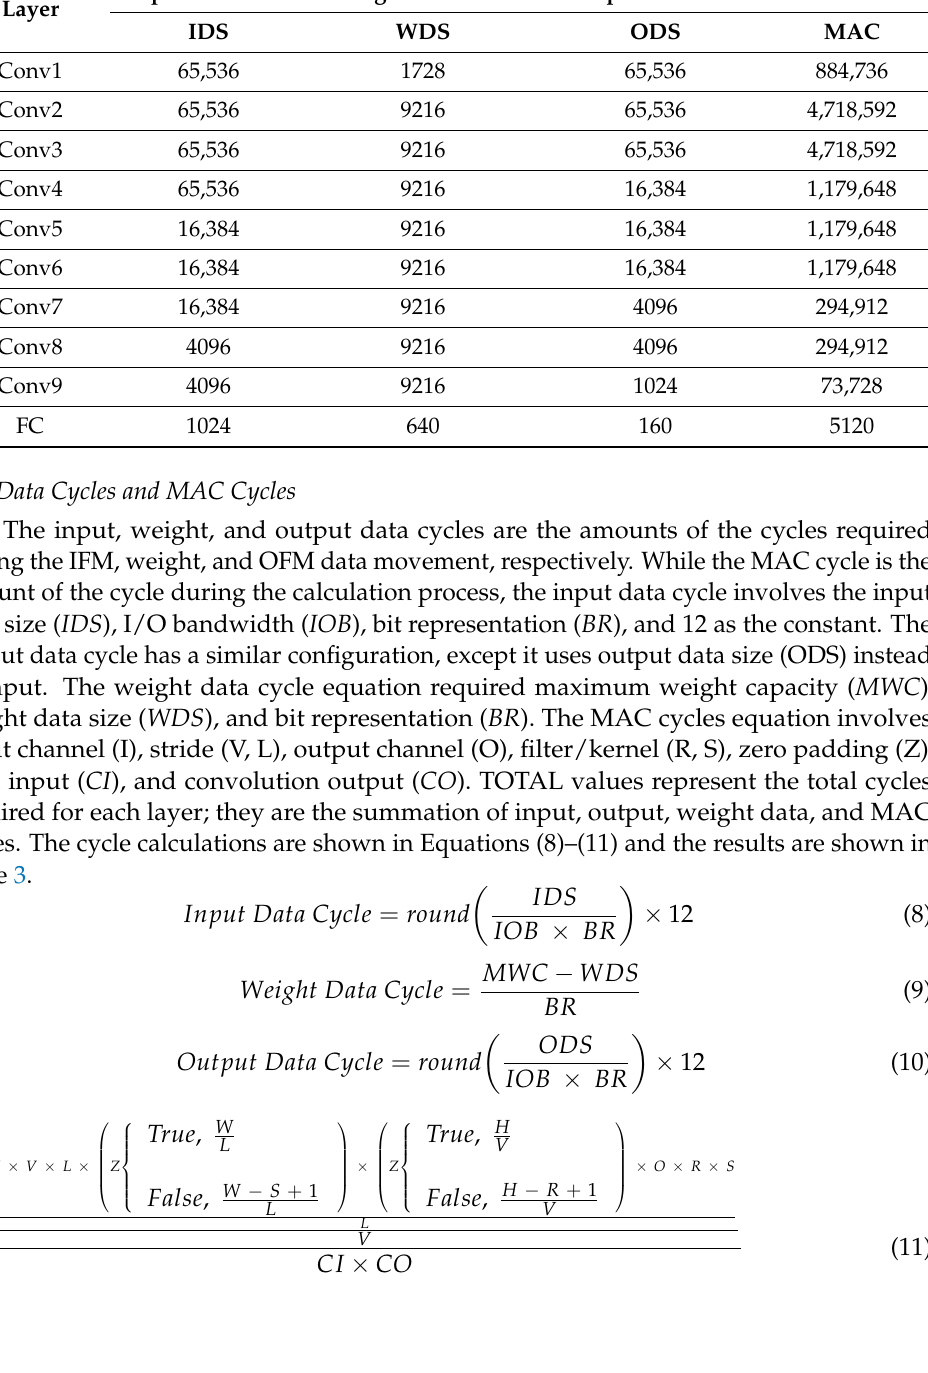
Table 2. Data size calculation based on the configuration and network parameters. Input Data Size Weight Data Layer